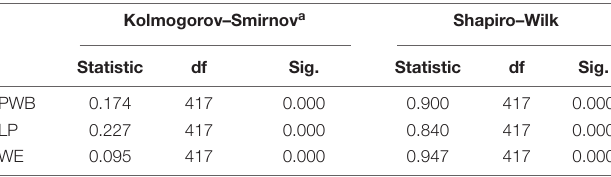
TABLE 2 | Test of normality for psychological well-being, loving pedagogy, work